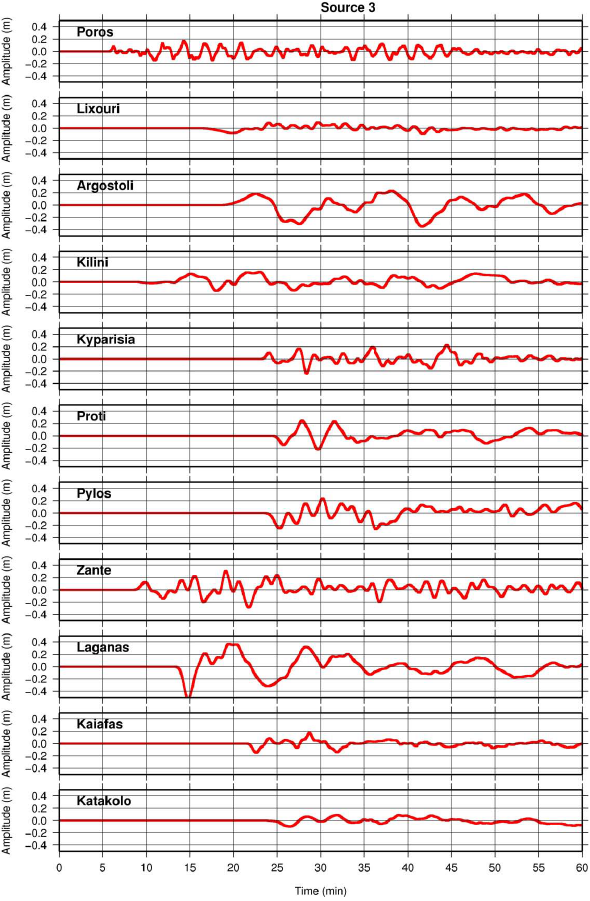
Fig. 9. Calculated mareograms at the locations shown in Fig. 4, for source 3 (Cephalonia South fault).